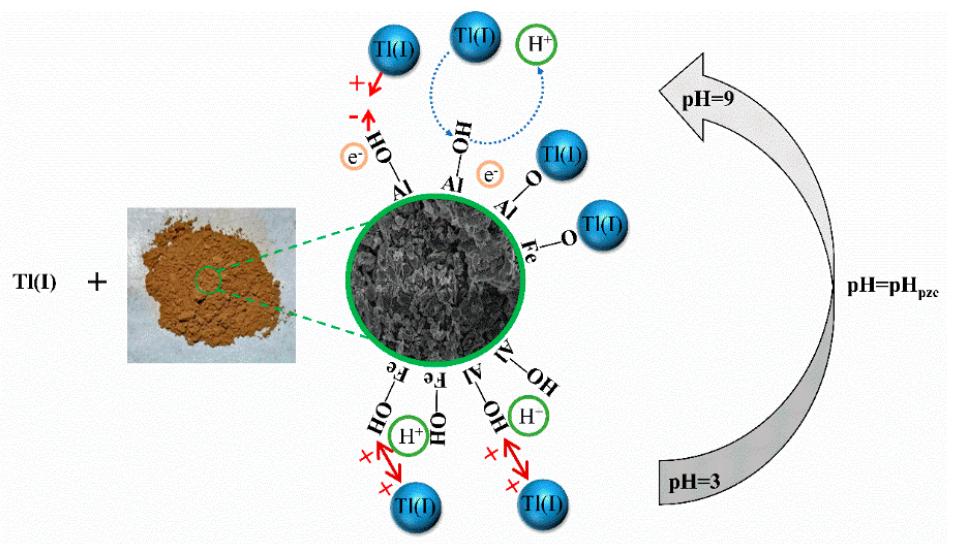
Figure 12. Mechanism diagram of Tl(I) adsorption by Al-WTR and Fe-WTR.